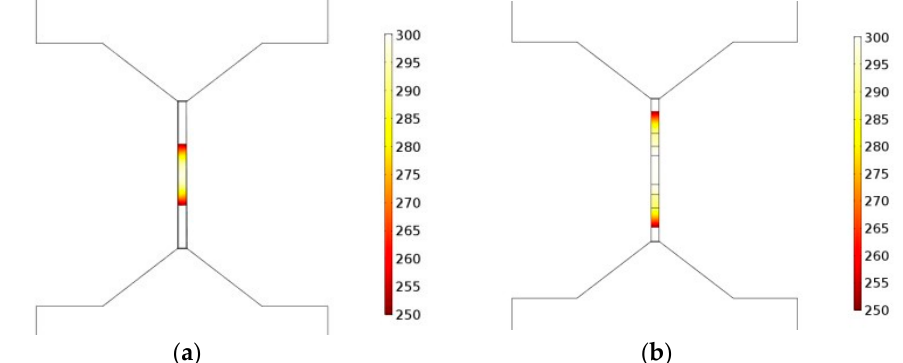
Figure 3. Temperature distribution [°C] over the active area of ( a ) the initial D02 design and ( b ) the novel composite heater